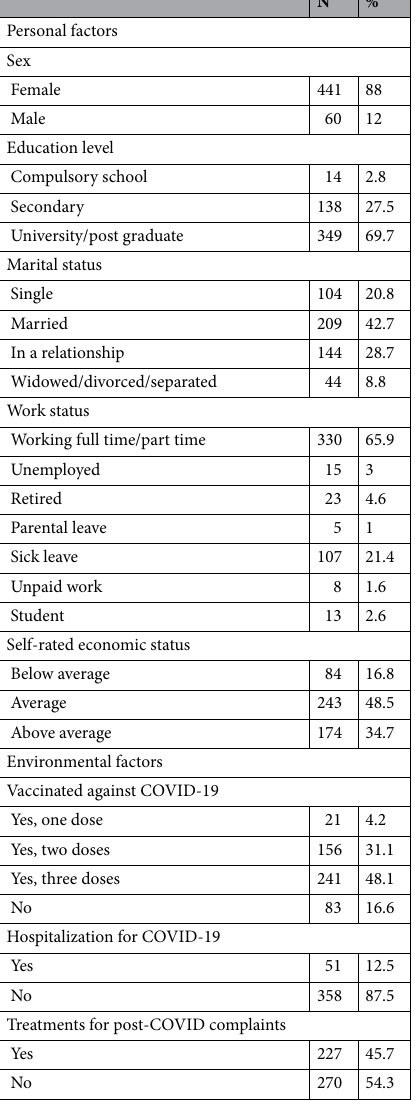
Table 1. Descriptive statistics of contextual factors including personal factors and environmental factors.